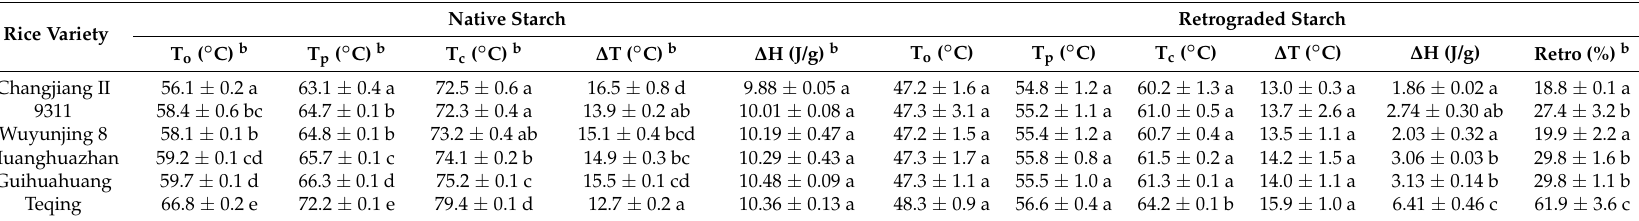
Table 4. Thermal parameters of native and retrograded starches a .